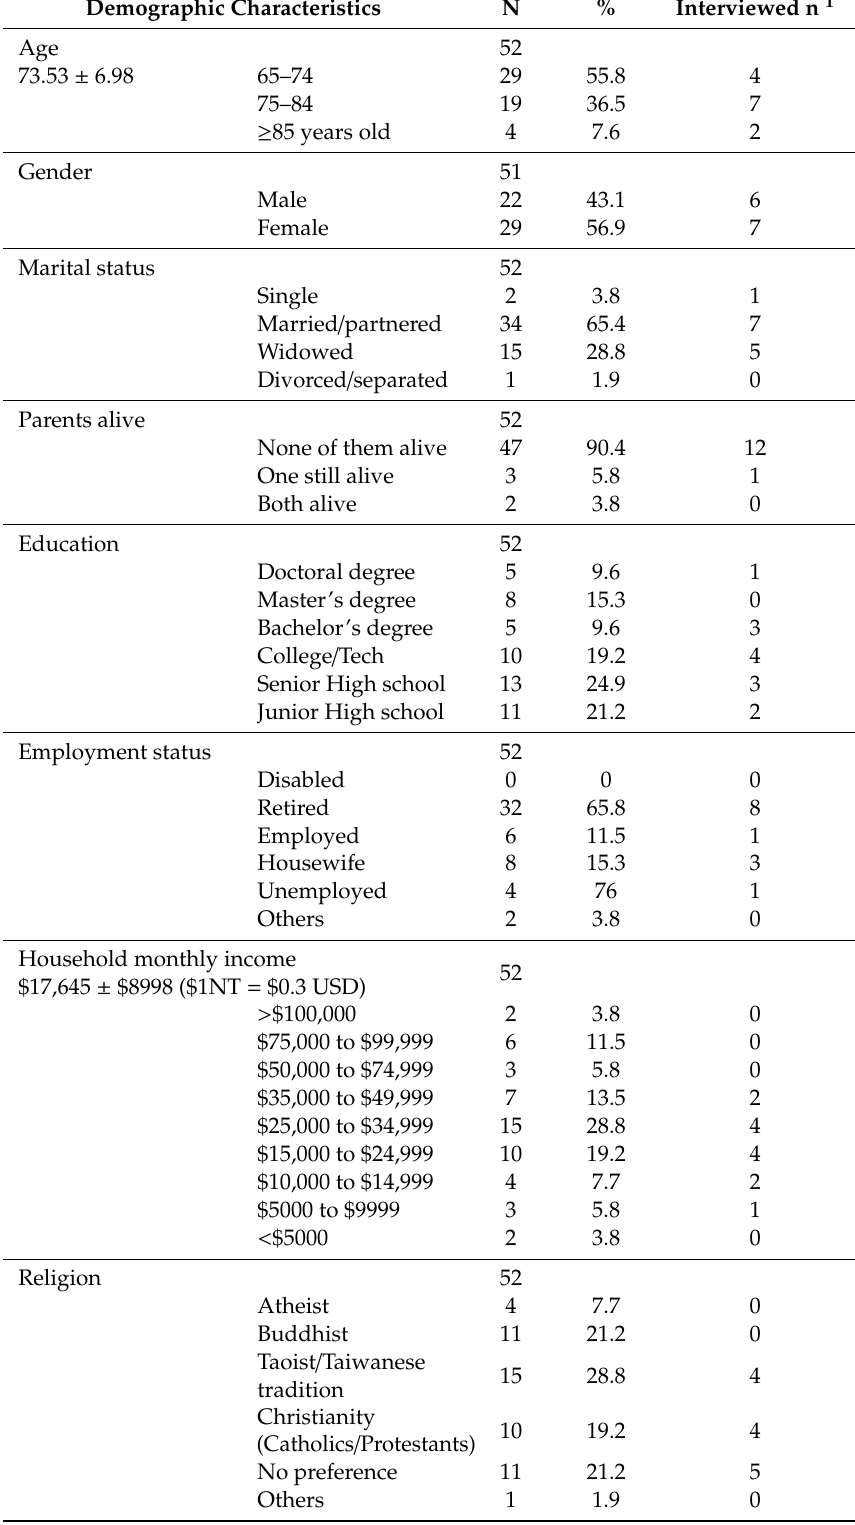
Table 2. Sample characteristics (N =